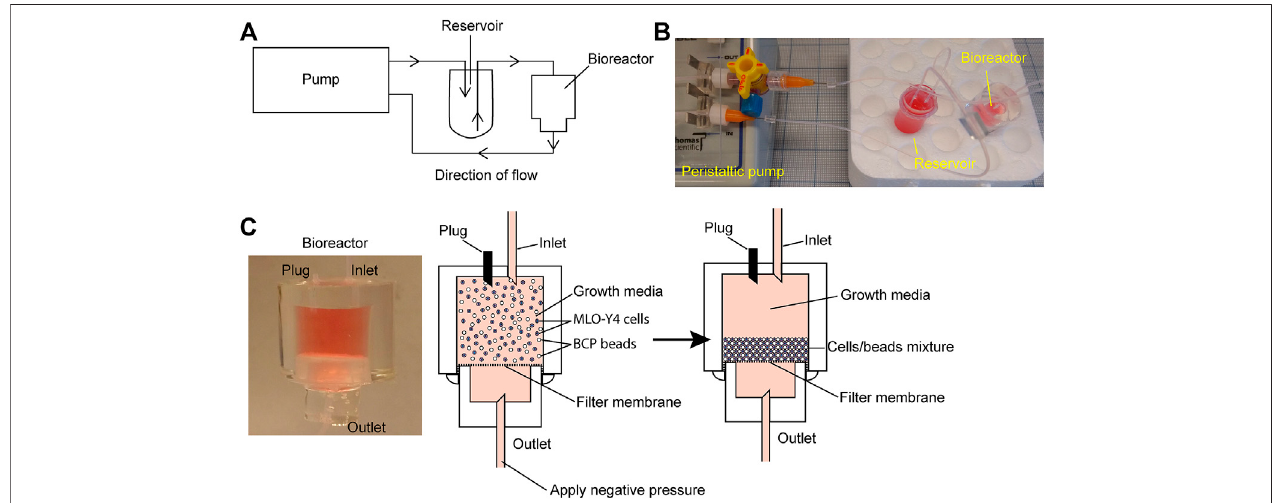
FIGURE1 | Bioreactor working model. (A) Schematic of thebioreactor system set up. (B) Image ofthebioreactor set up witha four-way stopcockintroduced into the circuit as a method of increasing system hydrostatic pressure. (C) Close-up image of the working bioreactor module (left panel); beads/cells suspension before packing (middle panel); and beads/cells suspension after packing (right panel).